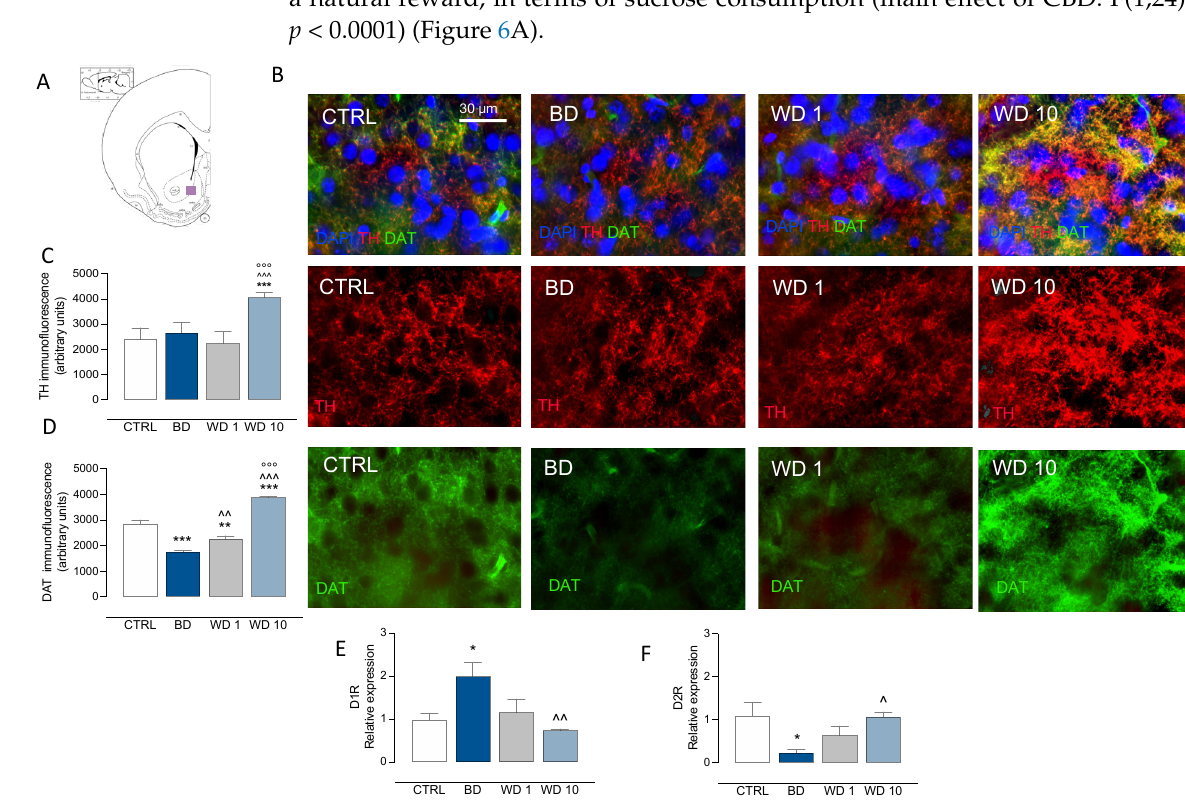
Figure 3. Binge-like alcohol exposure during adolescence alters DA signaling in the NAc. Rats exposed to binge-like alcohol drinking during adolescence show ( A – F ) altered pre- and postsynaptic markers of DA neurotransmission in the NAc. In particular, we observed ( B , C ) increased TH-positive immunofluorescence at WD10, when compared with CTRL (*** p < 0.001), BD (ˆˆˆ p < 0.001) and WD1 ( ◦◦◦ p < 0.001); on the other hand, we found ( B , D ) decreased DAT-positive levels at BD and WD1, when compared with CTRL (*** p < 0.001; ** p < 0.01), whereas DAT levels increase at WD10, with respect to CTRL (*** p < 0.001), BD (ˆˆˆ p < 0.001) and WD1 ( ◦◦◦ p < 0.001) groups. Opposite changes were observed in D1- and D2R expression levels ( E , F ). In detail, ( E ) D1R mRNA relative expression increased at BD with respect to the CTRL group (* p < 0.05), and decreased during withdrawal, with a significant decrease at WD10 when compared with BD (ˆˆ p < 0.01). On the other hand, ( F ) D2R mRNA relative expression significantly decreased at BD when compared with CTRL rats (* p < 0.05) and significantly increased at WD10, with respect to BD (ˆ p < 0.05). NAc: nucleus accumbens; TH: tyrosine hydroxylase; DAT: dopamine transporter; D1R: dopamine receptor 1; D2R: dopamine receptor 2; BD: binge day; WD1: withdrawal day 1; WD10: withdrawal day 10; CTRL: water-exposed control group. Each bar represents the mean of n = 7 rats; error bars indicate SEM. All expression values were normalized to control